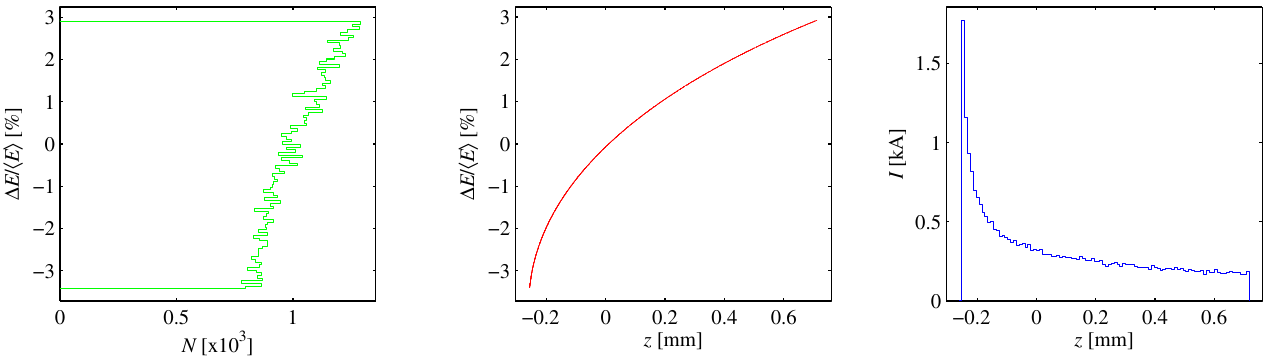
FIG. 4. (Color) Energy profile (left), longitudinal phase space (middle), and beam current distribution (right) after the bunch compressor chicane without passive linearizer or active fourth-harmonic system. An undesirable sharp current spike develops at the bunch head due to the quadratic term in the rf followed by the chicane compression. Bunch head at left, z < 0 .